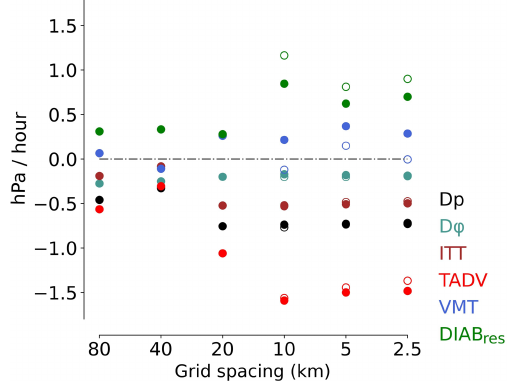
Figure 12. PTE terms as a function of grid spacing for simulations with one-moment cloud microphysics. The terms are averaged over the intensification period of cyclone Vladiana from 22 September 2016 at 22:00 to 23 September 2016 at 09:00 (between 10 and 21h after 22 September 2016 at 12:00). Filled and empty markers rep- resent simulations with parameterized and explicit convection, re-